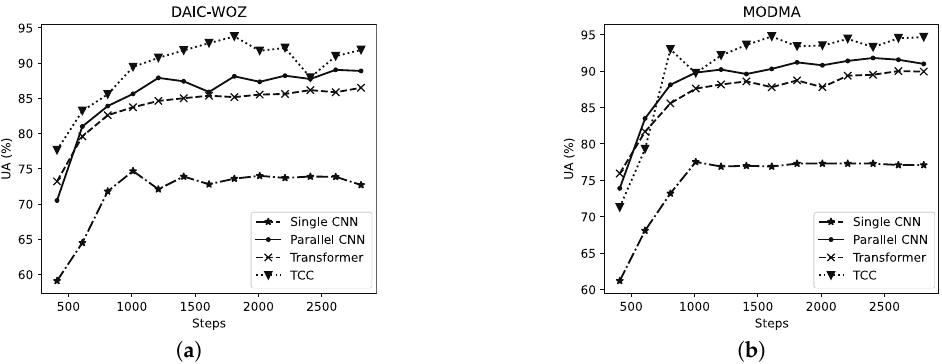
Figure 3. The unweighted accuracies (%) of single CNN, parallel CNN, transformer, and the proposed TCC model on ( a ) DAIC-WOZ and ( b ) MODMA datasets.